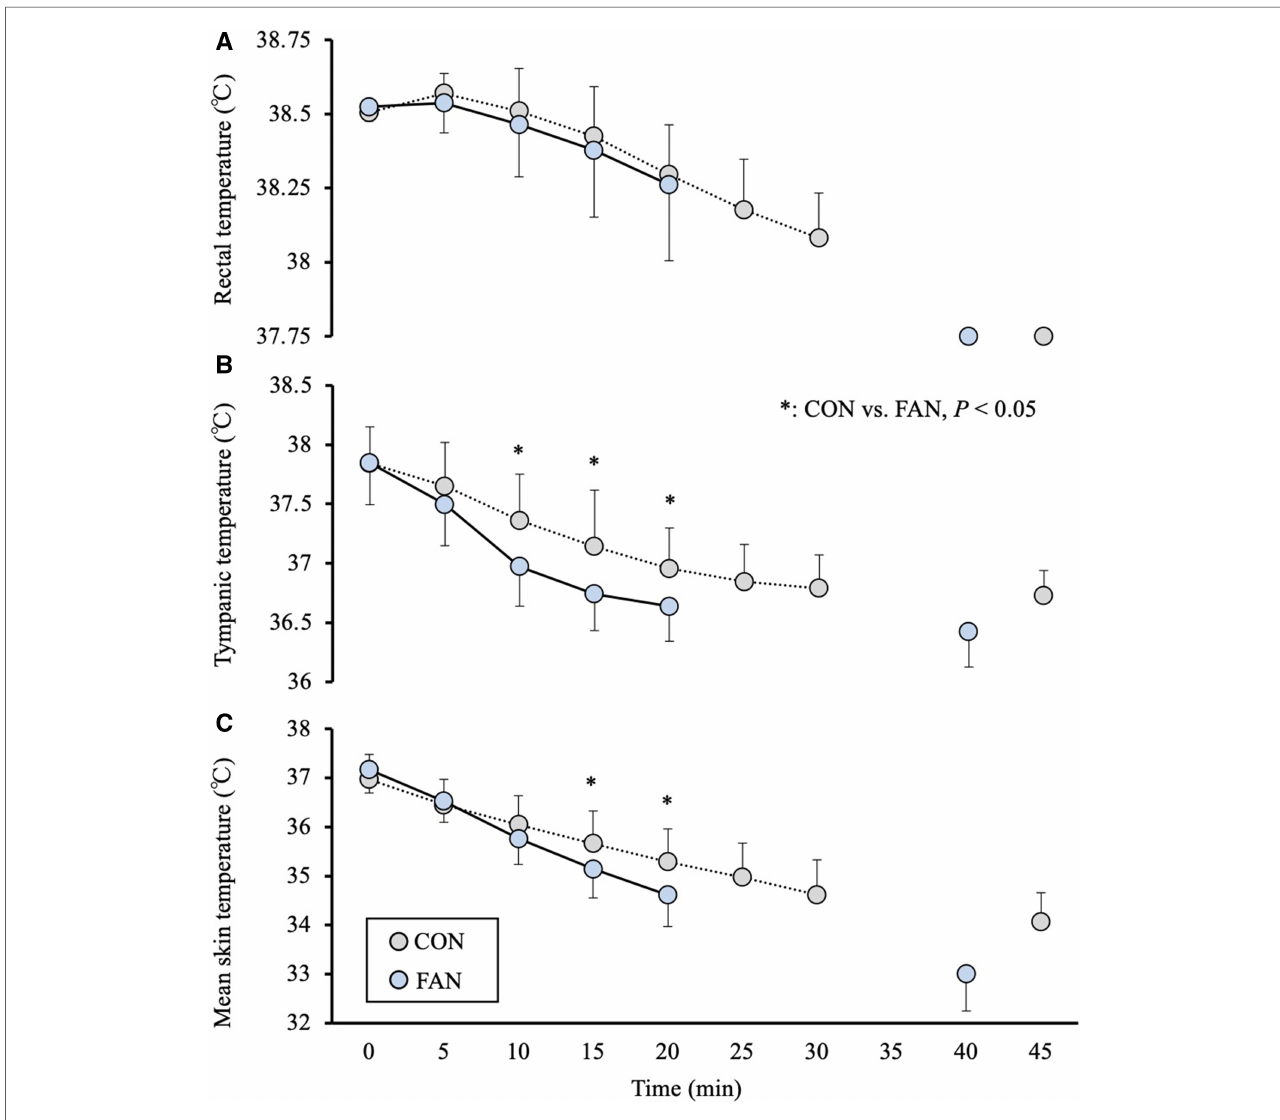
FIGURE 2 The rectal ( A ), tympanic ( B ) and mean skin temperatures ( C ) under the CON and FAN trials. Time×Trial effect CON vs. FAN: * P <0.05.